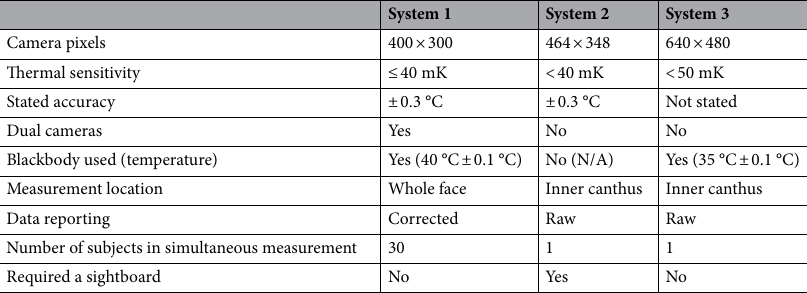
Table 1. Specifications of the IRT systems used in the study.